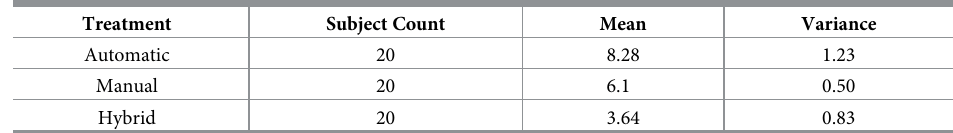
Table 5. Data summary—Group #2.